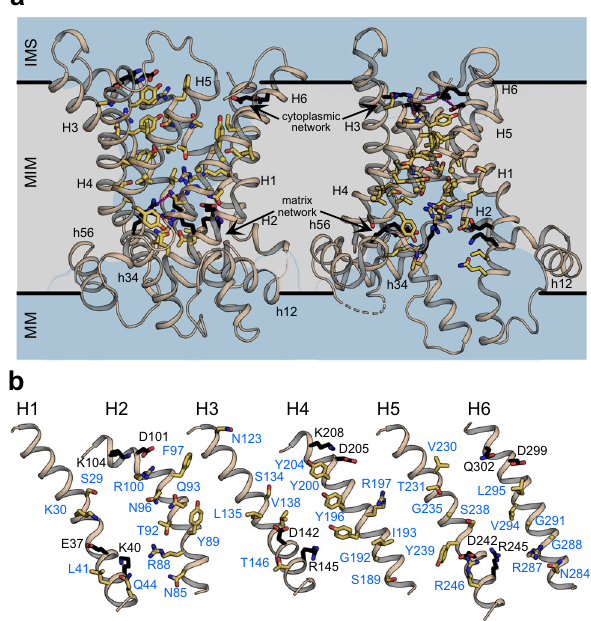
Fig. 1 The amino acid residues of the translocation pathway analysed in the study. a Membrane view of homology model of TtAac in the cytoplasmic-open state (left) and the experimentally determined structure of TtAac in the matrix-open state (right) (PDB code: 6gci chain A). The residues analysed in this study are indicated as yellow sticks, whereas the residues of the matrix and cytoplasmic networks as black sticks, with ionic interactions shown as magenta dashes. The water-accessible surfaces, determined by HOLE 59 , are shown in transparent blue. b Residues of the transmembrane helices lining the translocation pathway, analysed in this study, are labelled in blue, and the residues of the salt bridge networks in